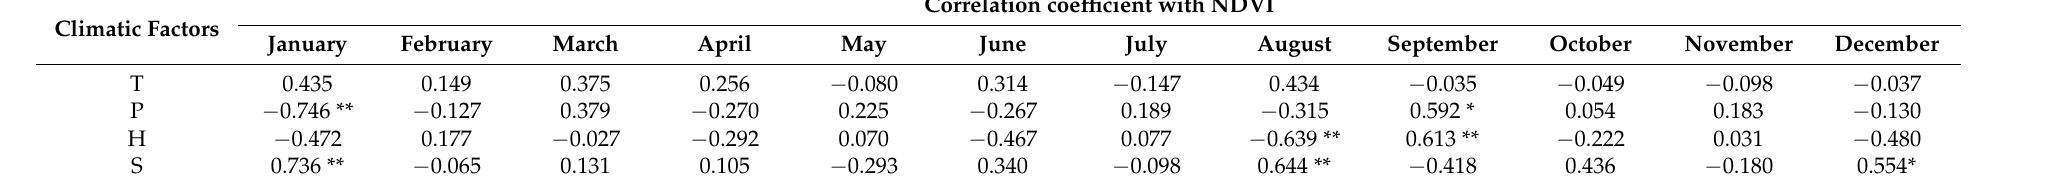
Table 8. Pearson correlation coefficients between plantation vegetation NDVI in each month and climatic factors in current and previous one, two, and three months,